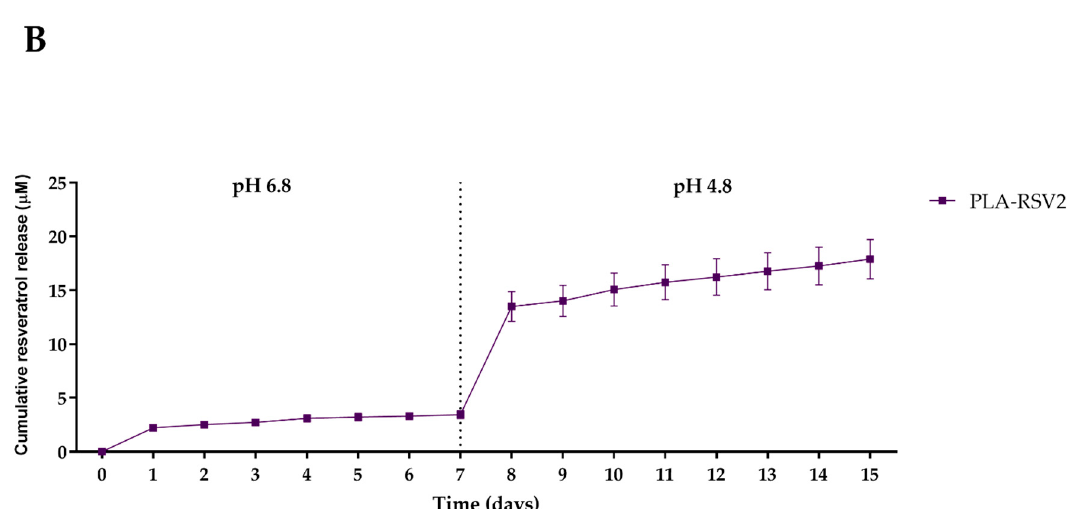
Figure 3. ( A ) In vitro drug release profiles at 37 °C of PLA-RSV membranes incubated for 46 days in artificial saliva supplemented with sucrose (SAGF-suc) at pH 4.8 and pH 6.8. ( B ) In vitro drug release profiles of PLA-RSV2 membrane in SAGF-suc at pH 6.8 from 0 to 7 days and at pH 4.8 from 8 to 15 days. For each sample, six different experiments were conducted, and the results expressed as the mean of the values obtained (mean ± SD). Statistically significant variations: §§§ p < 0.001 and § p < 0.05 versus pH 6.8.